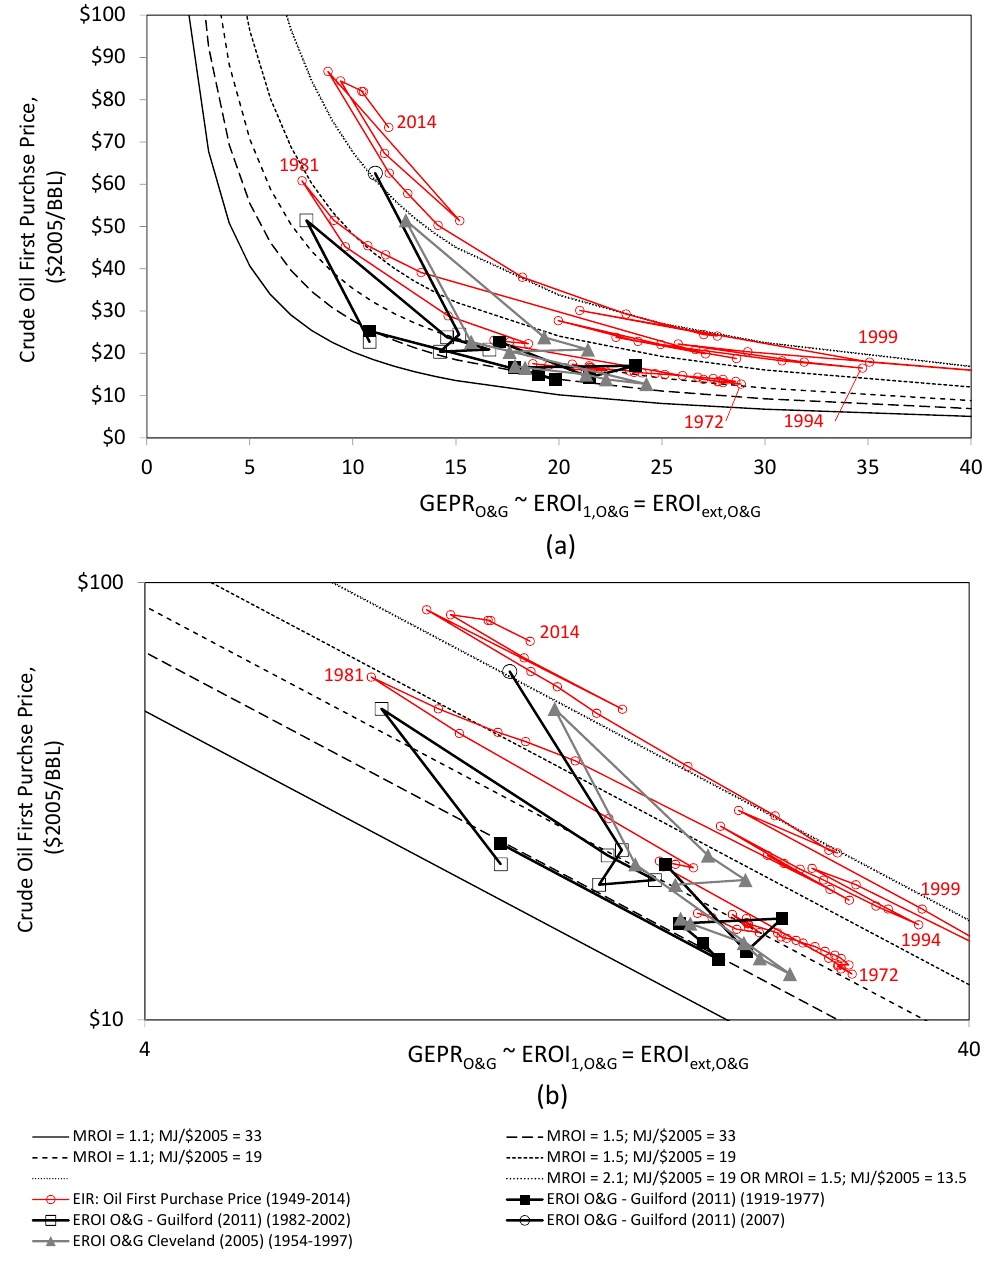
Figure 7. U.S. oil first purchase price versus both EIR oil and EROI 1 = EROI ext = GEPR as calculated by [21,51] for the U.S. oil and gas sector. Both figures show the same data: ( a ) uses linearly-scaled axes; and ( b ) uses logarithmically-scaled axes. See King and Hall [15] for a full explanation. Oil prices are annual U.S. crude oil first purchase prices from the Energy Information Administration’s Annual Energy Review and Monthly Energy Review. MROI = monetary return on investment relating to annual profit (MROI = 1 is